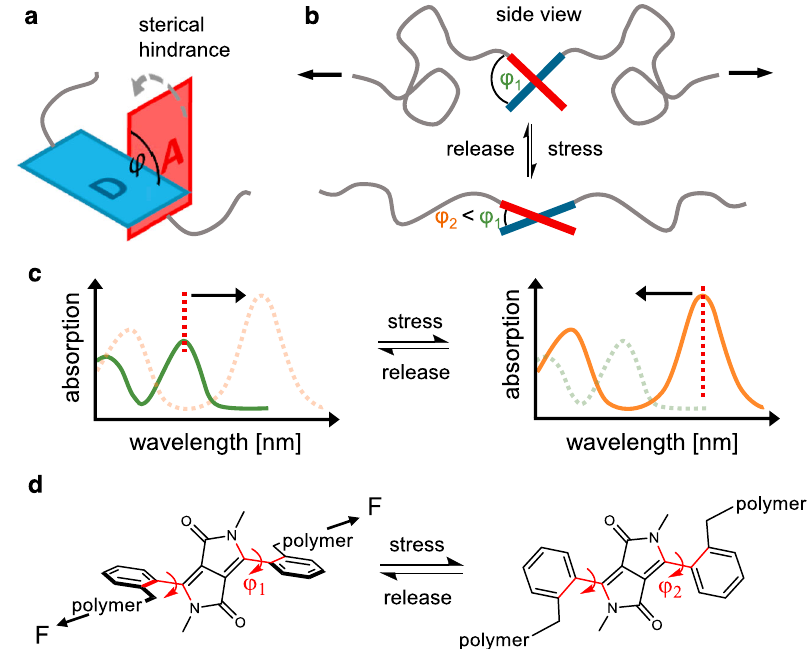
Fig. 1 Principle of a mechanochromic torsional spring. a A donor-acceptor (DA) unit with a large torsional angle φ is covalently incorporated into a polymer chain. b Stretching of the polymer backbone causes a decrease of φ . c Schematic reversible shift of the UV-vis-absorption band as a response to elongational stress. d Structure of the DA-system reported here based on diphenyldiketopyrrolopyrrole (PhDPP).